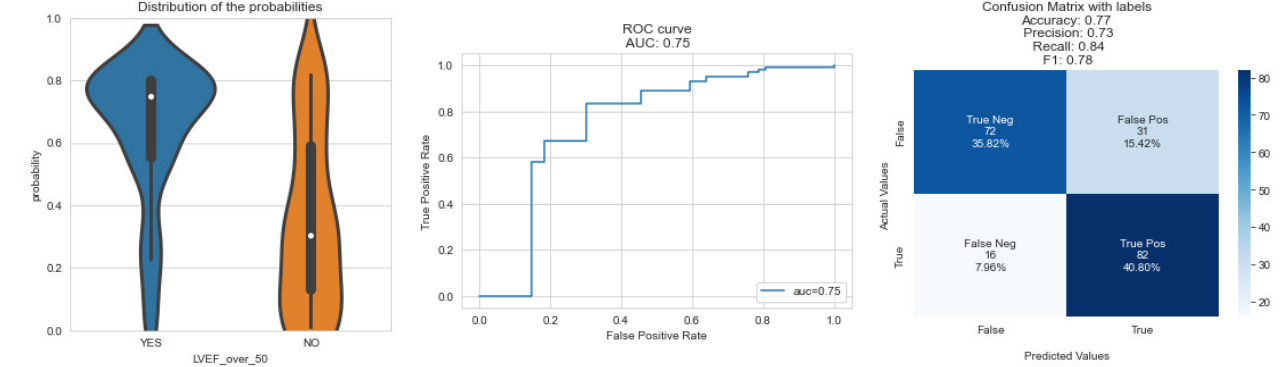
Figure 5. Classification results for social variables. The use of these independent variables largely explains LVEF in patients. Next, it is important to see how the contribution of these variables is divided individually. In order to better understand the role played by the variables in calculating the probabilities, they are analyzed by Shap Values, and the results are presented in Figure 6.